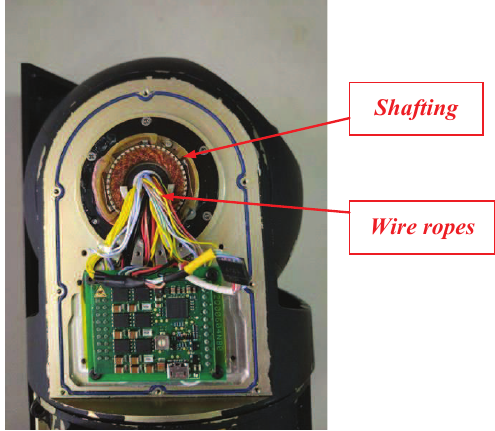
Figure 4. Side elevation drawing of a